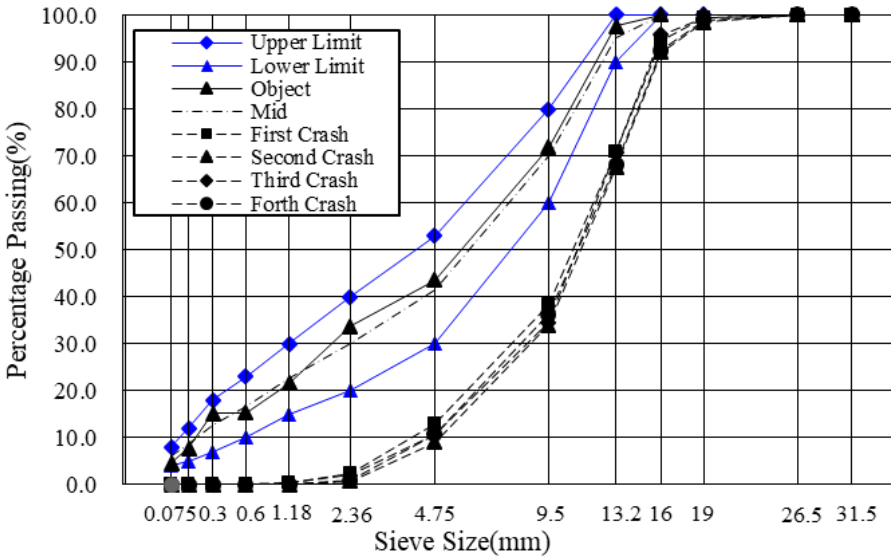
Figure 3. Grading curves for aggregates and crushed RAP.